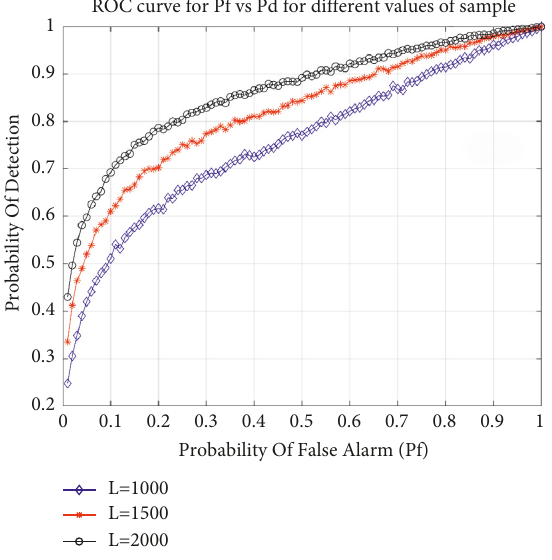
Figure 9: P f vs. P d at different sample